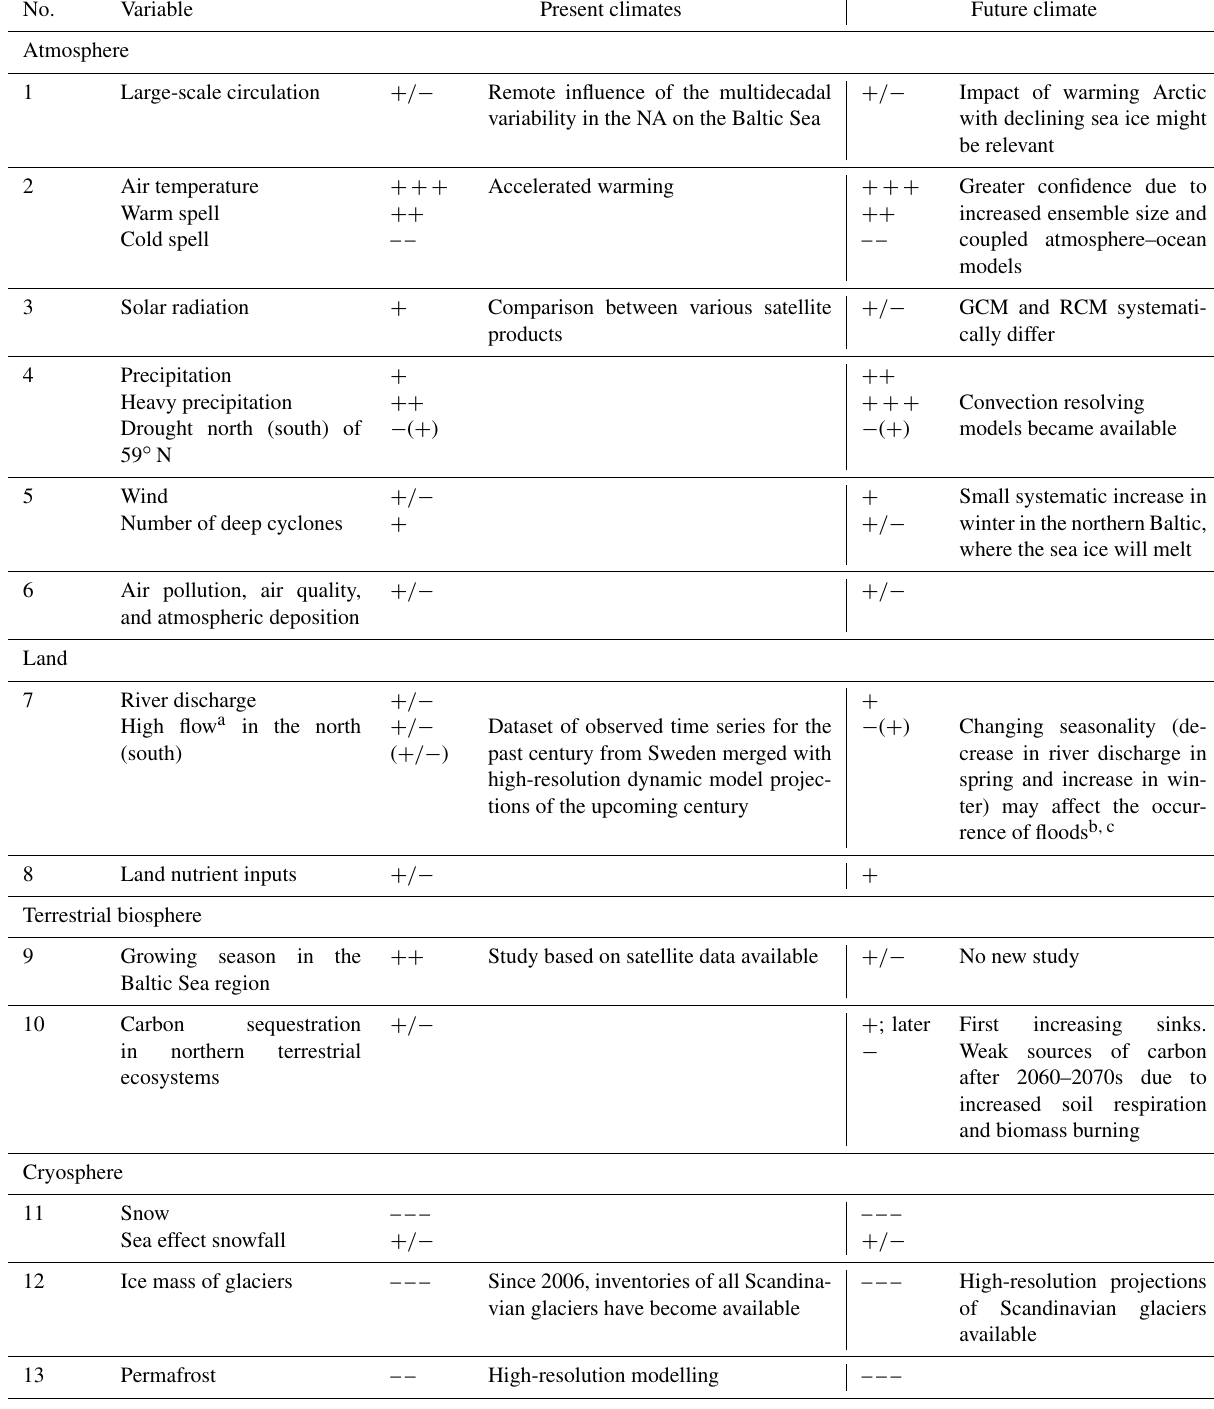
Table 15. Summary of the key messages about the impact of global warming on selected variables. The sign of a change (plus or minus) is listed together with the level of confidence denoted by the number of signs, i.e. one to three signs corresponding to low, medium, and high confidence levels. The plus/minus signs mean no detected or projected change due to climate change. The key messages of this assessment that are new, compared to the previous assessment by the BACC II Author Team (2015), are marked, and a brief explanation is provided in the neighbouring column. Note: NA is North